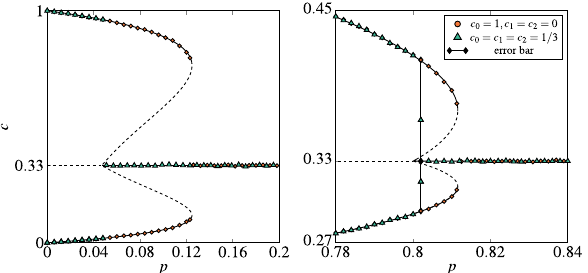
Figure 6. Dependence between the stationary concentration of agents in state 0 and probability of independence p within the annealed (left panel) and the quenched (right panel) approach for q = 5 and s = 3 . Lines represent the solutions of Eqs. (12) and (30): solid and dashed lines correspond to stable and unstable steady states, respectively. Symbols represent the outcome from MC simulations for the system size N = 5 × 10 5 . The results are averaged over ten runs and collected after t = 10 5 MCS. Simulations are performed from two different initial conditions indicated in the legend. To compare analytical with MC results we plotted also error bars, but for almost all values of p they are invisible, i.e. smaller than the symbols representing